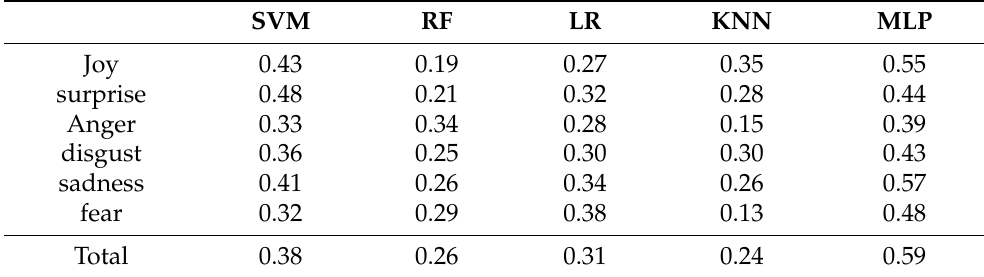
Table 2. Comparison of different classifiers’ results on the BAUM-1s dataset.